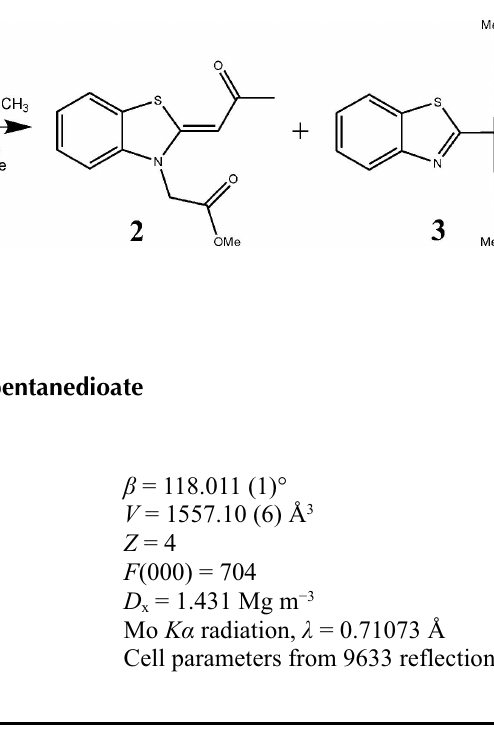
Figure 1 Thermal ellipsoid plot of the title compound with the atomic numbering scheme used. With exception of the hydrogen atoms, which are represented as spheres of arbitrary radius, all other atoms are shown as thermal displacement ellipsoids (oxygen = white, one octant; carbon = grey; nitrogen = white; sulfur = grey, one octant) representing the 50% probability level.